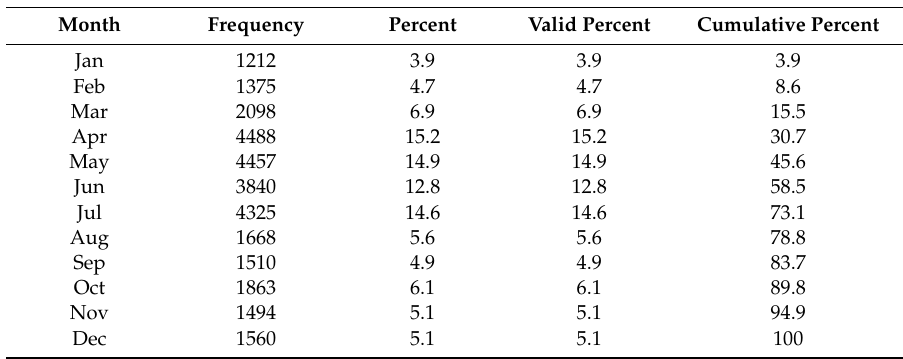
Table 6. Check-in